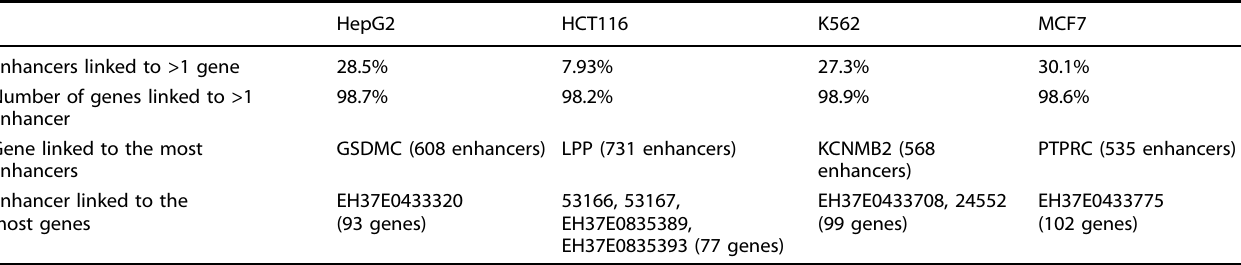
Table 5. Genome-wide enhancer-gene regulatory